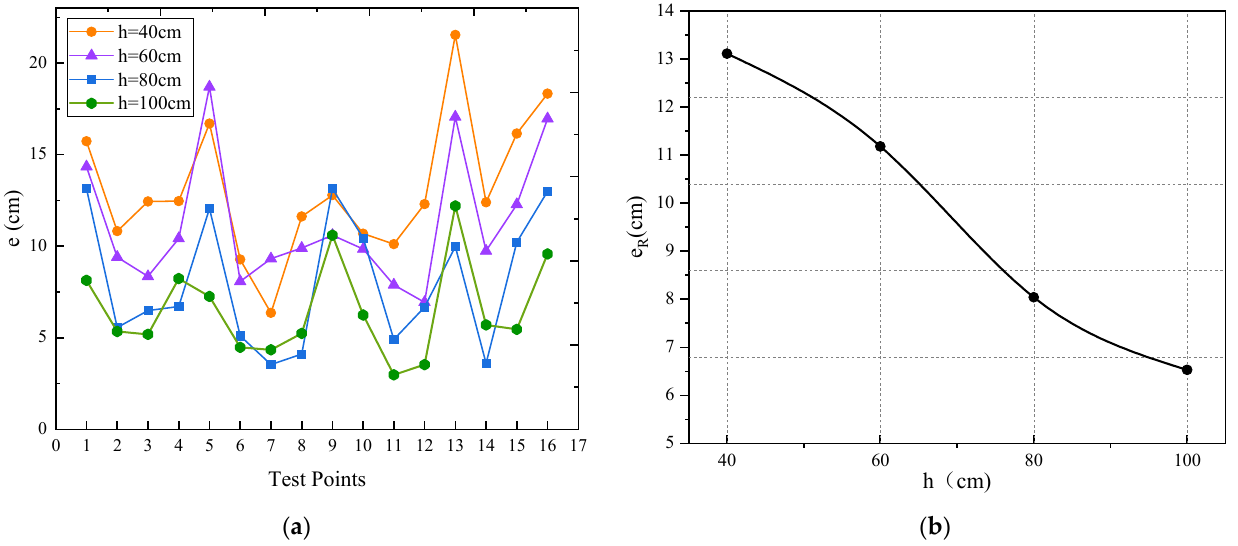
Figure 16. Positioning error of the precise positioning algorithm: ( a ) positioning error of each test point at different test heights; ( b ) average error per height.